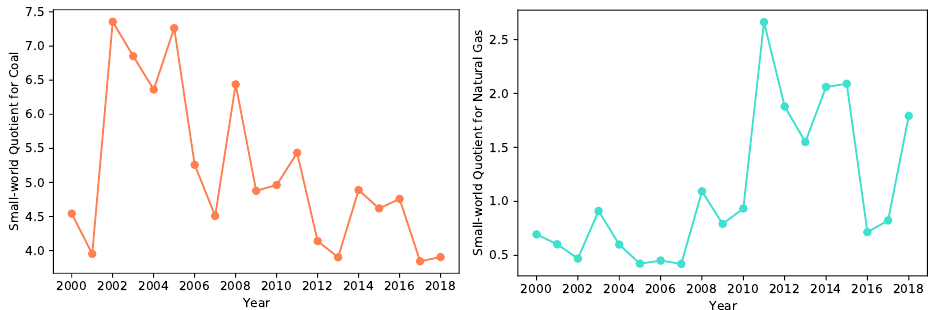
Figure 11. The evolution of small-world coefficient for coal ( left ) and natural gas ( right